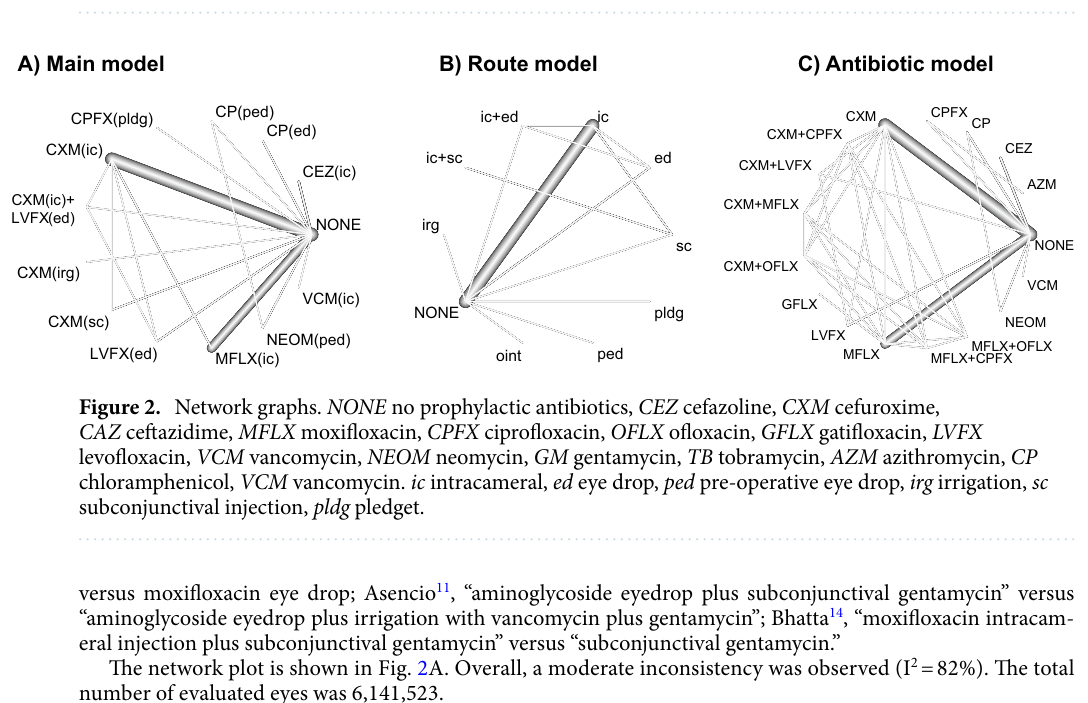
Table 1. Characteristics of included studies. RCT, randomized controlled trial; Pro, prospective observational study; Retro, retrospective observational study. NOS, The Newcastle–Ottawa Scale. NONE, no prophylactic antibiotics; CEZ, cefazoline; CXM, cefuroxime; CAZ, ceftazidime; MFLX, moxifloxacin; CPFX, ciprofloxacin; OFLX, ofloxacin; GFLX, gatifloxacin; LVFX, levofloxacin; VCM, vancomycin; NEOM, neomycin; AG, aminoglycoside; GM, gentamycin; TB, tobramycin; AZM, azithromycin; CP, Chloramphenicol. (ic), intracameral; (ed), eye drop; (ped), pre-operative eye drop; (irg), irrigation; (oint), ointment; (sc), subconjunctival injection; (pldg), pledget; (top), topical.